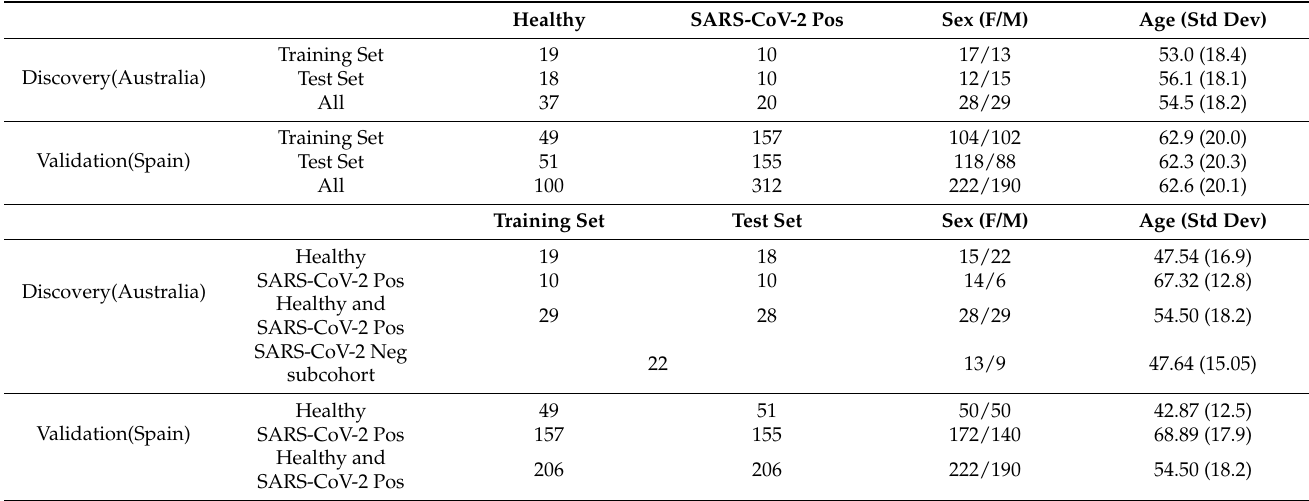
Table 1. Patient samples in the discovery and validation datasets (healthy controls vs. SARS-CoV-2-positive